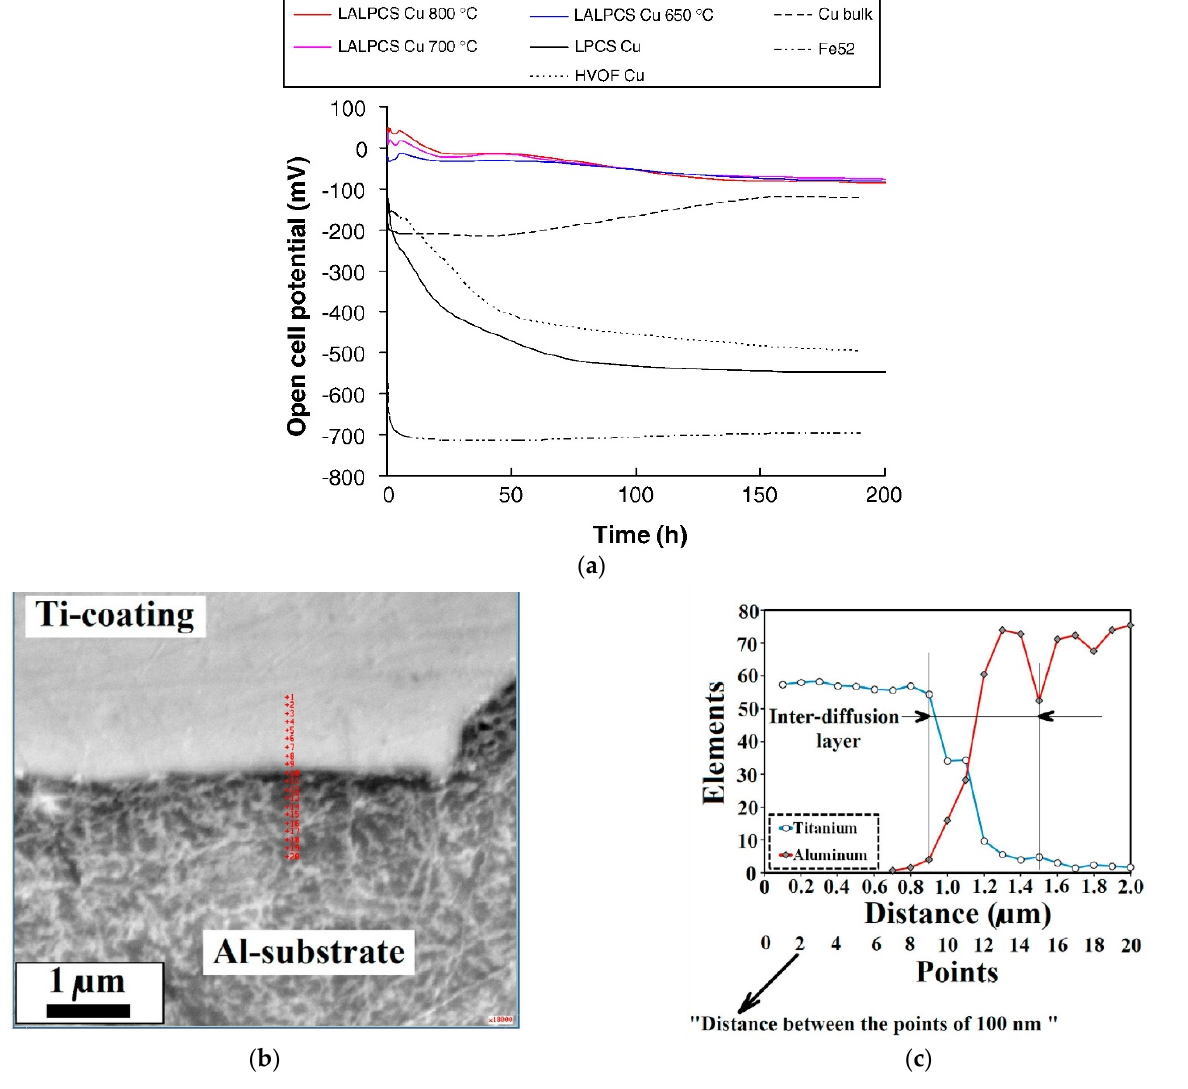
Figure 18. Open-cell potential versus time for the LALPCS and LPCS Cu+Al 2 O 3 coatings and as references were HVOF sprayed Cu coating, bulk Cu and substrate material Fe 52 ( a ) (Reprinted with permission from [65]. Copyright 2008 Elsevier.) the SEM image from Al-Ti interface showing the indexing points for Auger analysis ( b ) and Auger electron spectroscopy line-scan analysis results from the interaction zone at the interface ( c ) (Reprinted with permission from [200]. Copyright 2018 Elsevier).